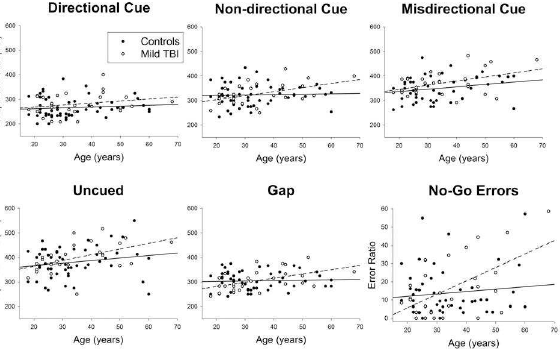
Fig 1. Linear regressions of age on individual BEAM trial types for controls (solid line) and mild TBI (dotted